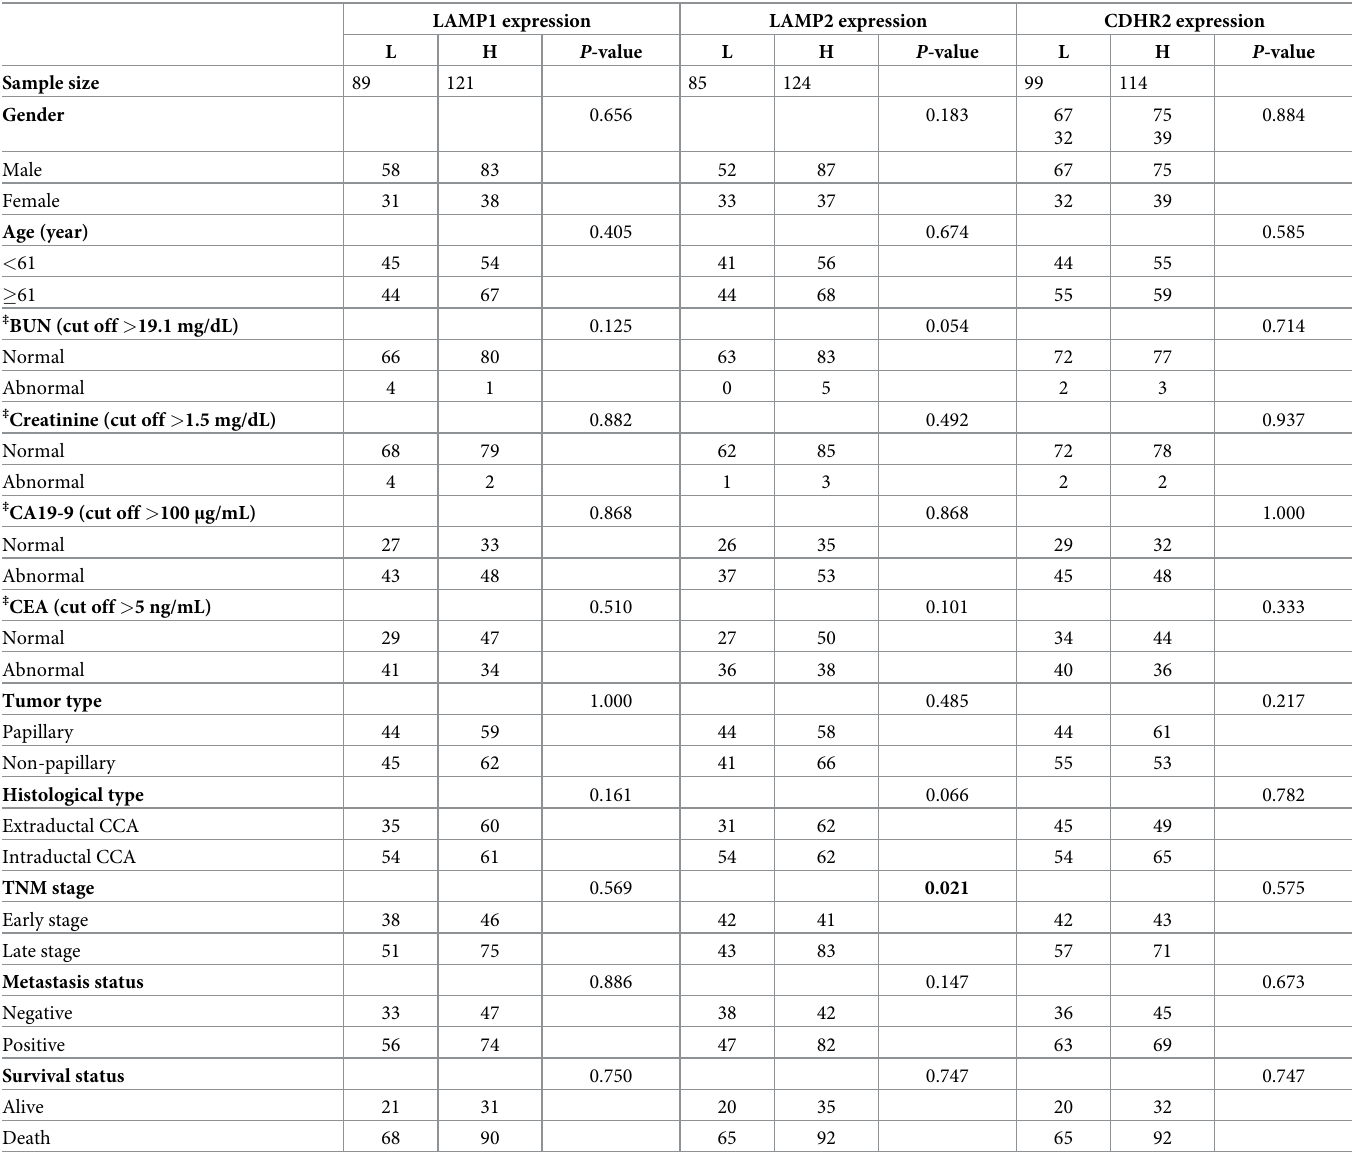
Table 3. Clinico-pathological data and urinary candidate